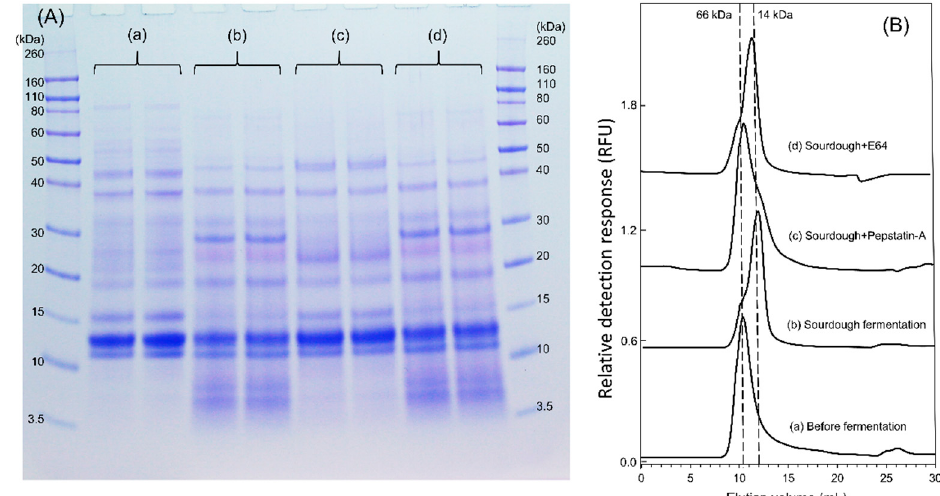
Figure 2. Effect of protease inhibitors on the wheat sourdough albumin/globulin extract and fluorescence-labelled ATI tetramer. ( A ) SDS-PAGE of albumin/globulin extract. (a) control before fermentation, (b) rye starter-wheat sourdough, pH was 3.6 after 17 h fermentation, (c) rye starter-wheat sourdough in the presence of 20 µM aspartic proteinase inhibitor Pepstatin-A, pH was 3.7 after 17 h fermentation, (d) rye starter-wheat sourdough in the presence of 10 µM cysteine proteinase inhibitor E-64, pH was 3.6 after 17 h fermentation. The replicates were from two individual fermentation. ( B ) Size-exclusion chromatogram of fluorescein isothiocyanate (FITC)-labelled ATI tetramer after sourdough fermentation in the presence of protease inhibitors. The samples were treated the same as in ( A ). Fluorescent detector was set at excitation 488 nm and emission 530 nm. Elution volume of molecular marker bovine serum albumin (66 kDa) and lysozyme (14 kDa) was indicated in broken lines.